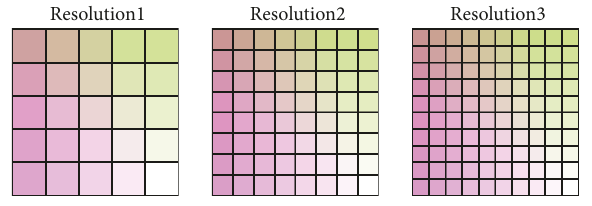
Figure 3: The three adopted HOG